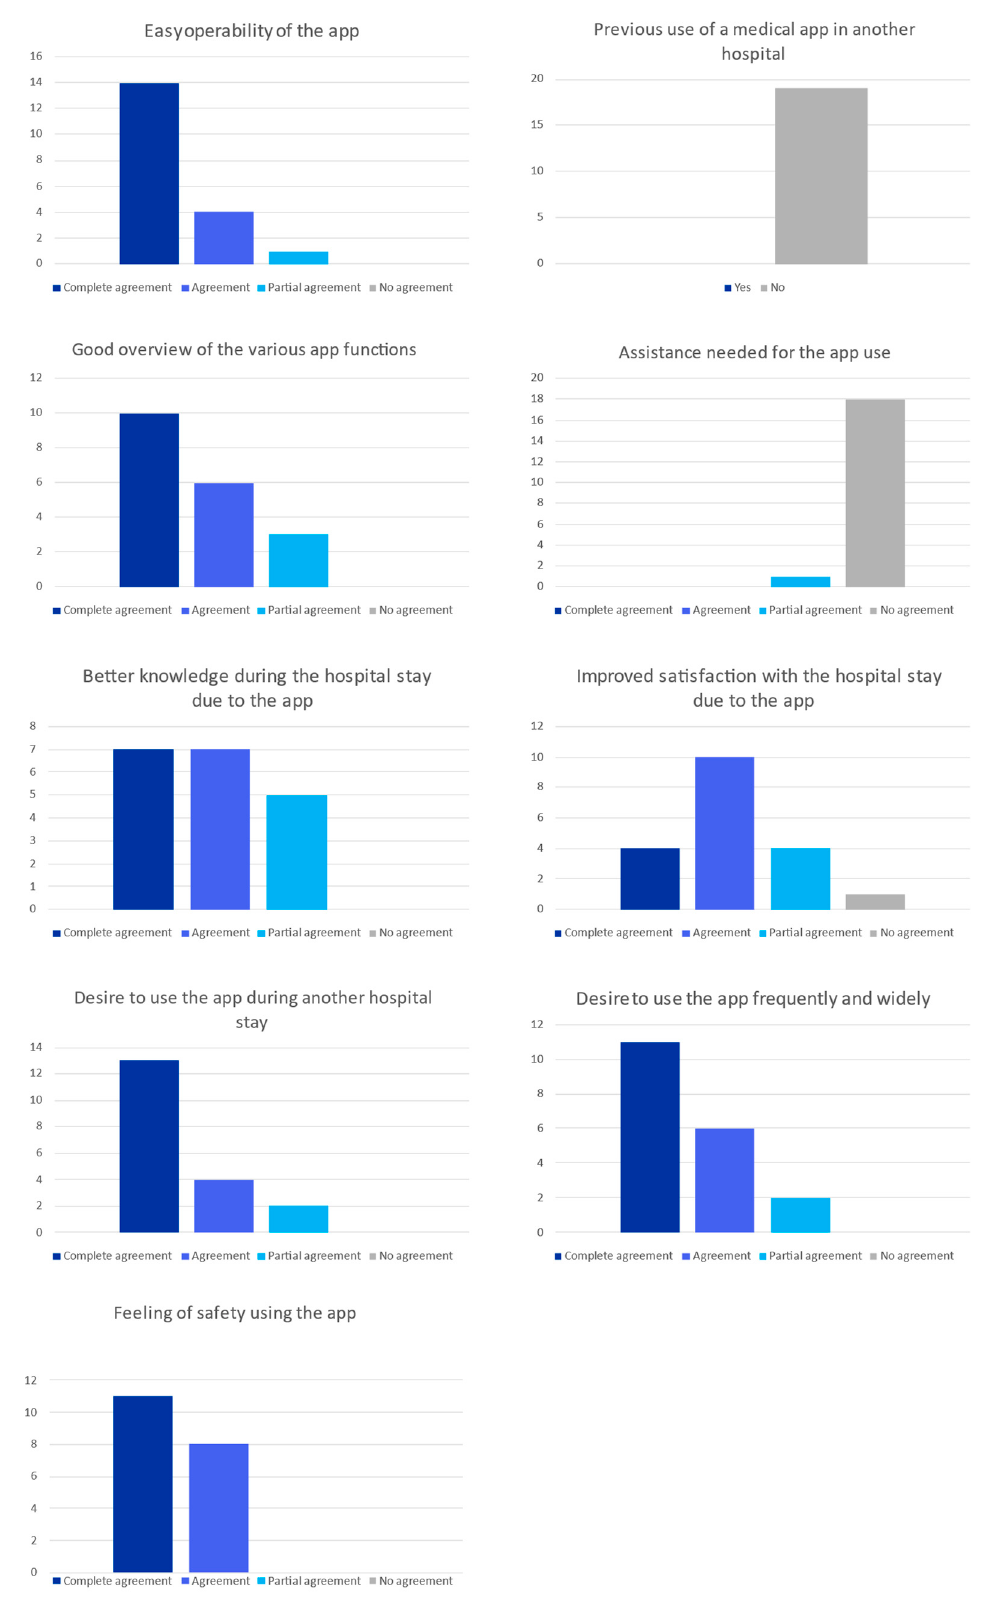
Figure 3. Evaluation of patient satisfaction with the PIA app. The evaluation of the app was obtained after use via structured questionnaires. A total of 19 out of 22 recruited patients gave feedback about the PIA app, which is shown